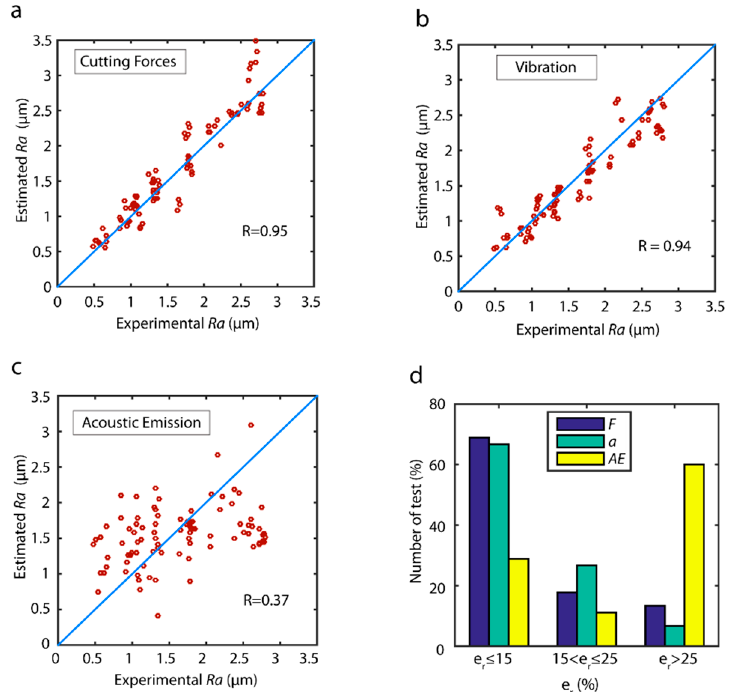
Figure 15. Estimated data versus experimental validation data for the parameter Ra : ( a ) cutting forces, ( b ) vibration, and ( c ) acoustic emission. ( d ) Reliability of predictive models.